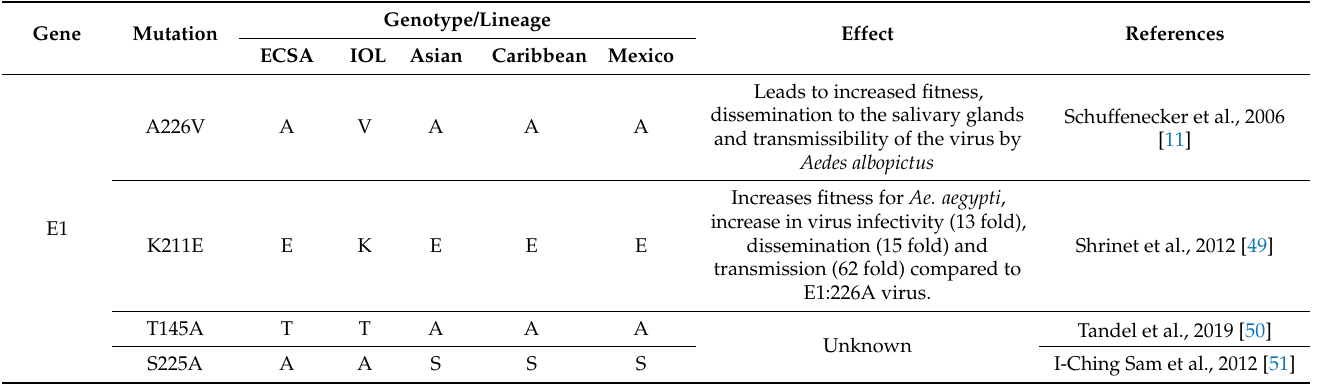
Table 2. Amino Acid Changes Identified among ECSA, IOL, Asian, Caribbean and Mexican CHIKV